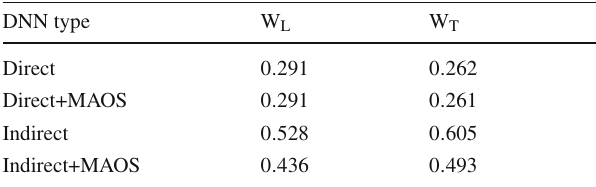
Table5 RMSEbetweenthethetrueandreconstructedcos ϑ calculated as a quantitative parameter to evaluate the performance of applied DNN techniques. We are comparing neural networks trained in the fully- leptonicchannel.Modelsaretrainedandevaluatedonsamplesofpurely longitudinally polarized (W L ) and a purely transversely polarized (W T ) leptonicallydecaying W bosons and then direct and indirect approaches are used, with an optional inclusion of the MAOS and MT2 variables in the training, as described in the text. RMSE is equal to 0 in the case of